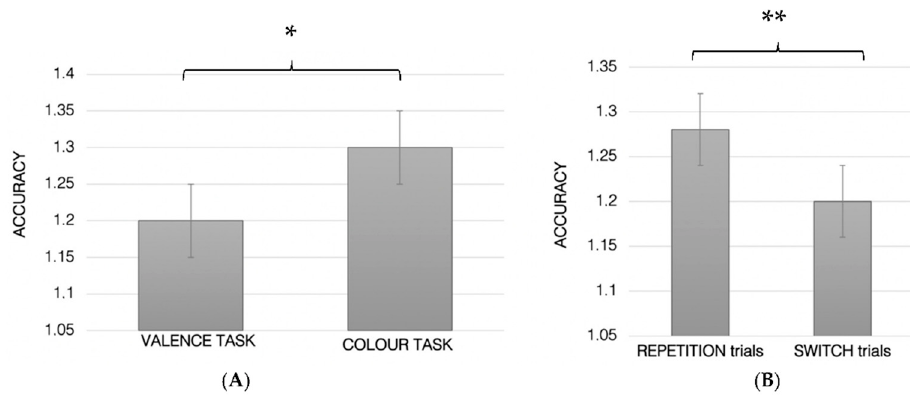
Figure 4. Accuracy in the Valence and Color task ( A ); reaction time in the repetition and switch trials